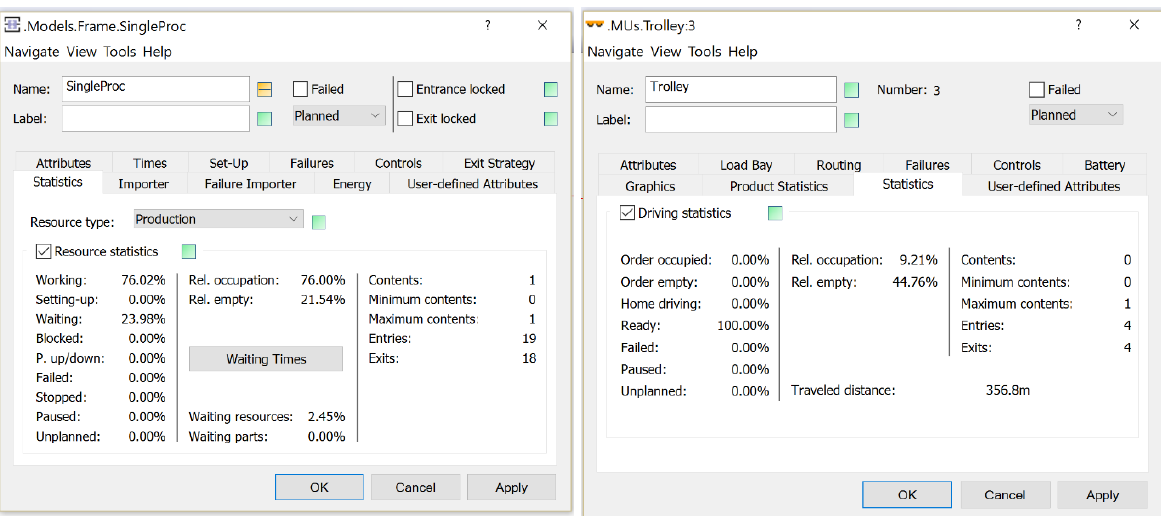
Figure 5: Example of the information available from the used blocks.